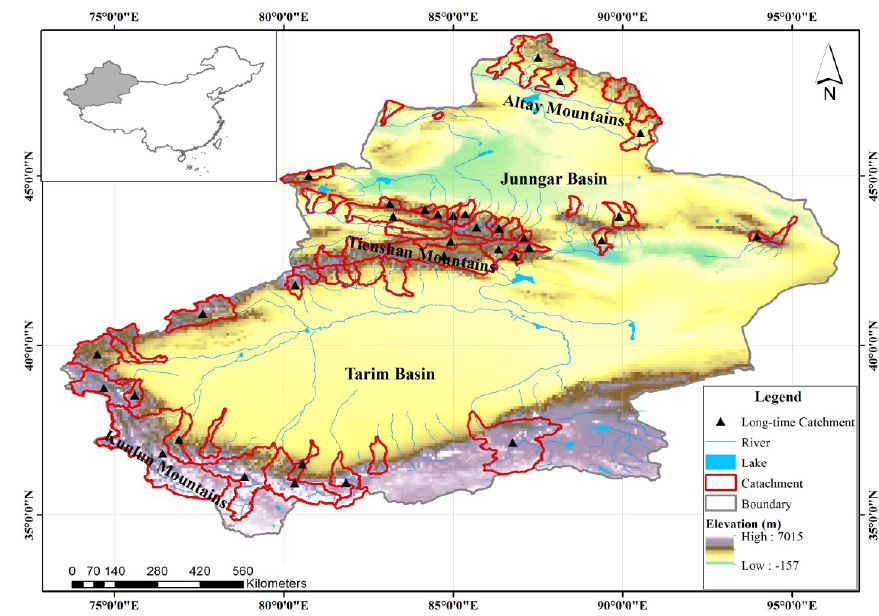
Figure 1. Spatial distribution of 64 catchments (red outlined) in Xinjiang. Black triangles denote a selected subset of 33 catchments with long‐term hydrologic data during 1970–2010.